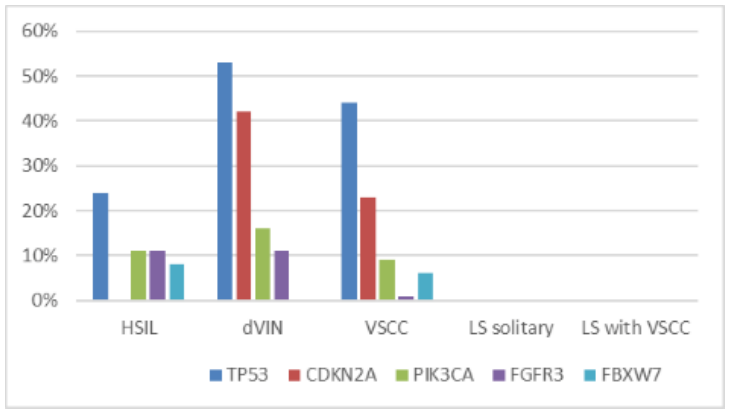
Figure 4. Mutation prevalence of the most often mutated genes in dVIN, HSIL, VSCC and LS samples. A total of 163 polymorphic changes in HSIL, dVIN and LS samples were localized in seven